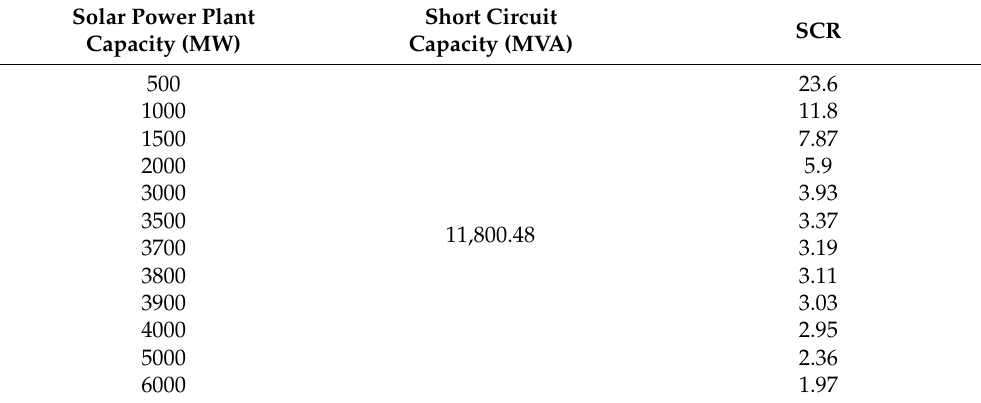
Table 4. Solar power plant sizes and SCR value (assuming no interaction).